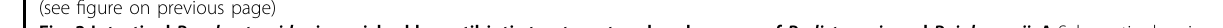
Fig. 3 Intestinal Parabacteroides is enriched by antibiotic treatment and oral gavage of P. distasonis and P. johnsonii . A Schematic showing the timeline for the experimental design of the Parabacteroides transfer experiment. B Alpha diversity based on 16S rRNA gene pro fi ling of fecal matter ( n = 7 – 8) represented by observed operational taxonomic units (OTUs) for a given number of sample sequences. C Principal coordinates analysis of weighted UniFrac distance based on 16S rRNA gene pro fi ling of feces for SAL – SAL, ABX-SAL, and ABX-PARA enriched rats ( n = 7 – 8). D Average taxonomic distributions of bacteria from 16S rRNA gene sequencing data of feces for SAL – SAL, ABX-SAL, and ABX-PARA enriched animals ( n = 7 – 8). E Relative abundances of Parabacteroides in fecal microbiota for SAL – SAL, ABX-SAL, and ABX-PARA enriched animals ( n = 7 – 8) (ANCOM). PN post-natal day, IP GTT intraperitoneal glucose tolerance test. Data are presented as mean ± S.E.M. * P < 0.05, ** P < 0.01, *** P < 0.001. n.s. not statistically signi fi cant, SAL – SAL rats treated with saline, ABX-SAL rats treated with antibiotics followed by sterile saline gavage, ABX-PARA rats treated with antibiotics followed by a 1:1 gavage of Parabacteroides distasonis and Parabacteroides johnsonii